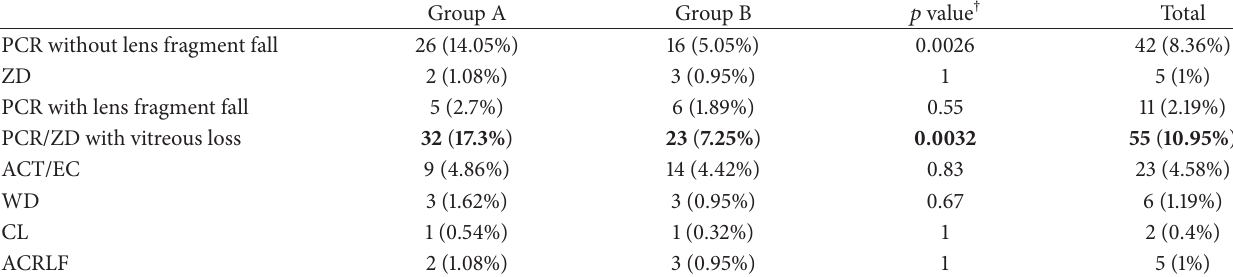
Table 2: Intraoperative complications rates of all study cases for each study group and respective 𝑝 values. Percentages are given in